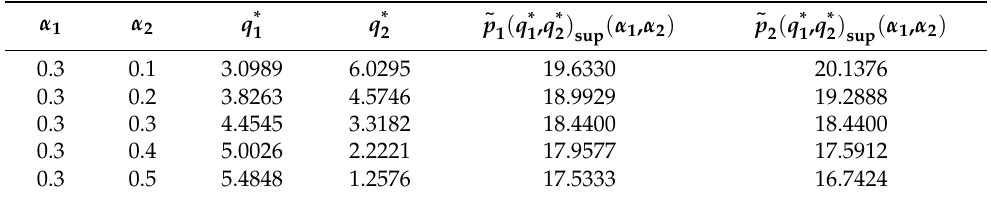
Table 2. ( α 1 , α 2 )-optimistic equilibrium quantity for Scenario I when AG’s risk aversion levels